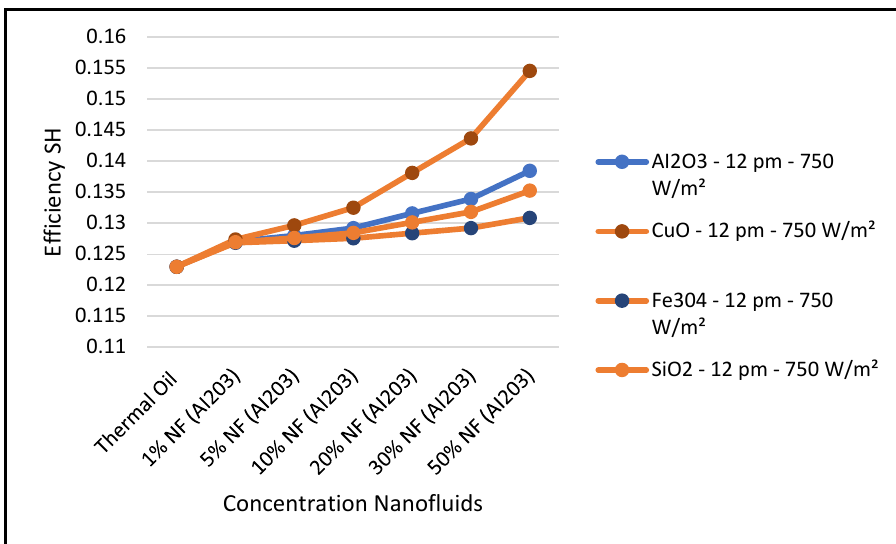
ffi ciency with di ff erent nanofluids at di ff erent Figure 28. CSP system hybrid efficiency with different nanofluids at different concentrations. Figure 28. CSP system hybrid e